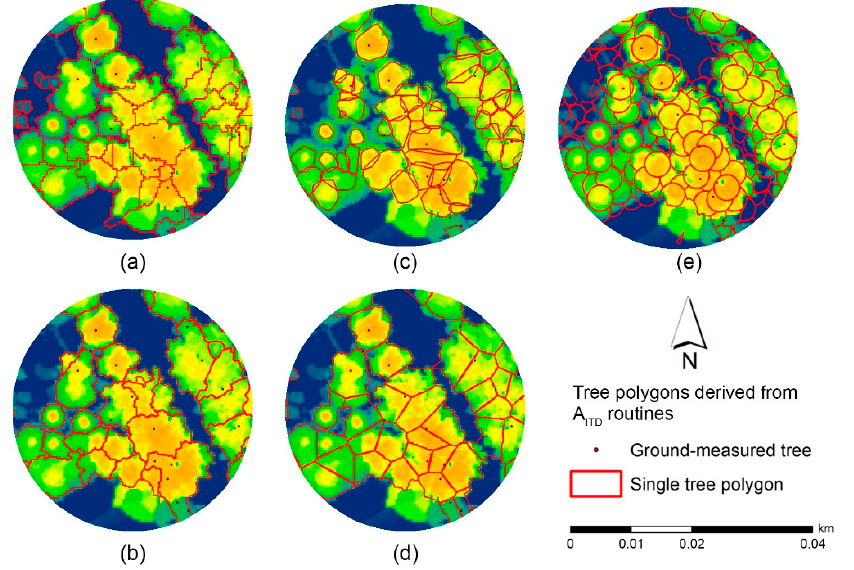
Figure 7. Individual trees depend on different A ITD routines: ( a ) marker-controlled watershed segmentation; ( b ) simple watershed segmentation; ( c ) A ITD by Dalponte and Coomes [68]; ( d ) A ITD by Silva et al. [69]; ( e ) A ITD by Li et al. [56].